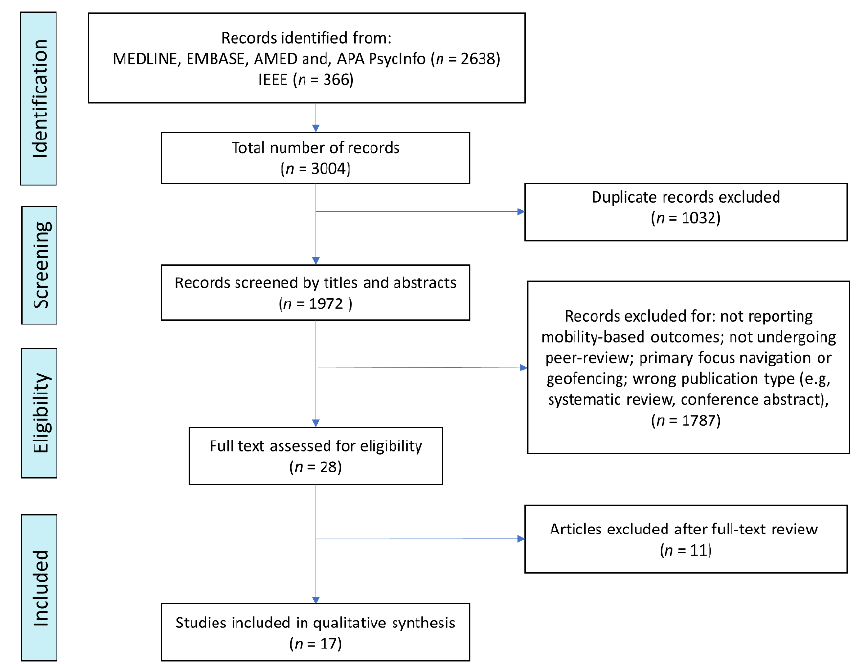
Figure 1. PRISMA flowchart summarising the search process and results.